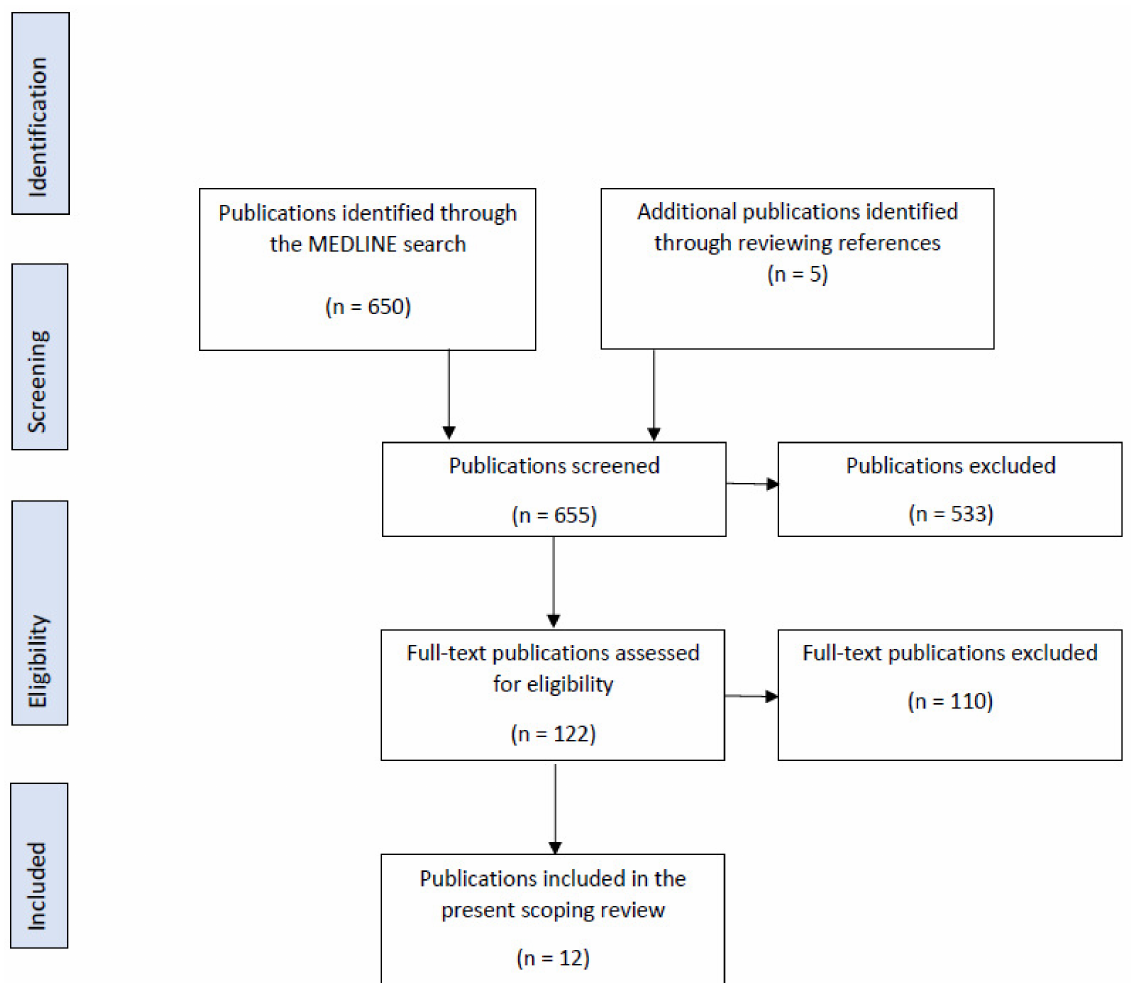
Figure 1. PRISMA Flow Diagram for the scoping review